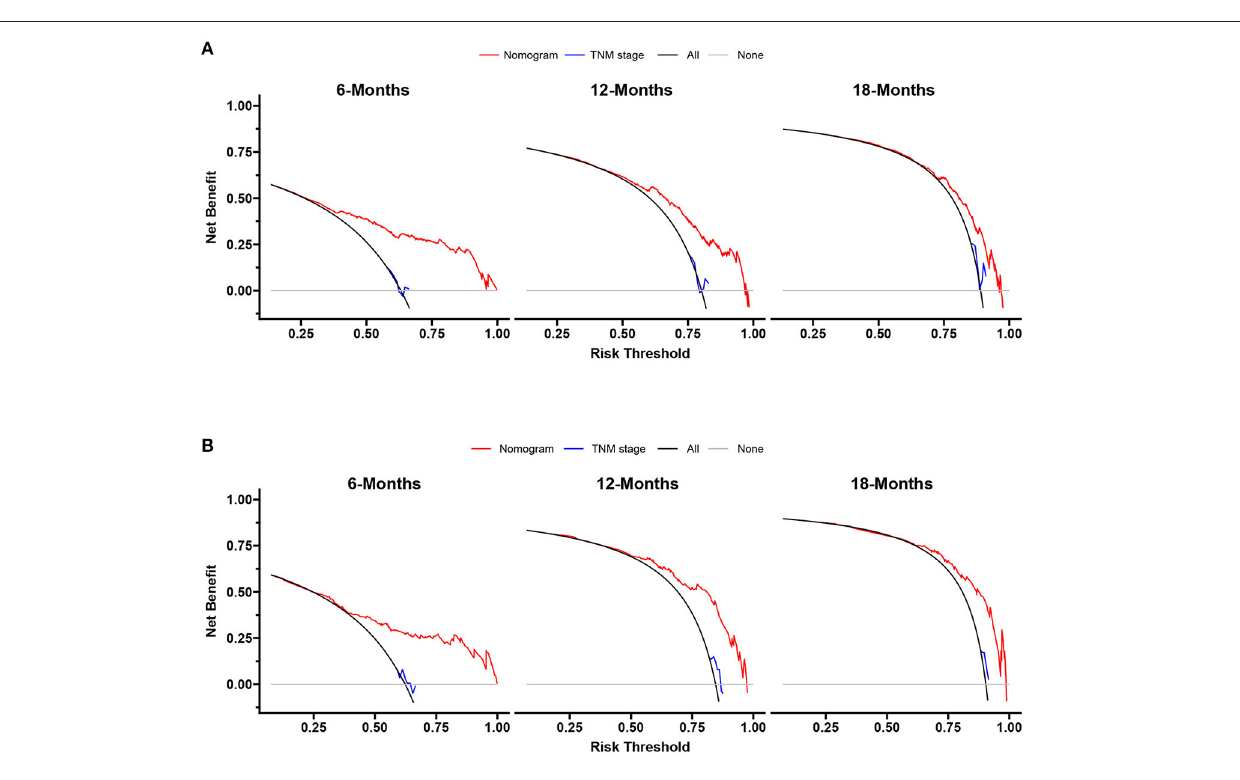
Frontiers in Public Health |